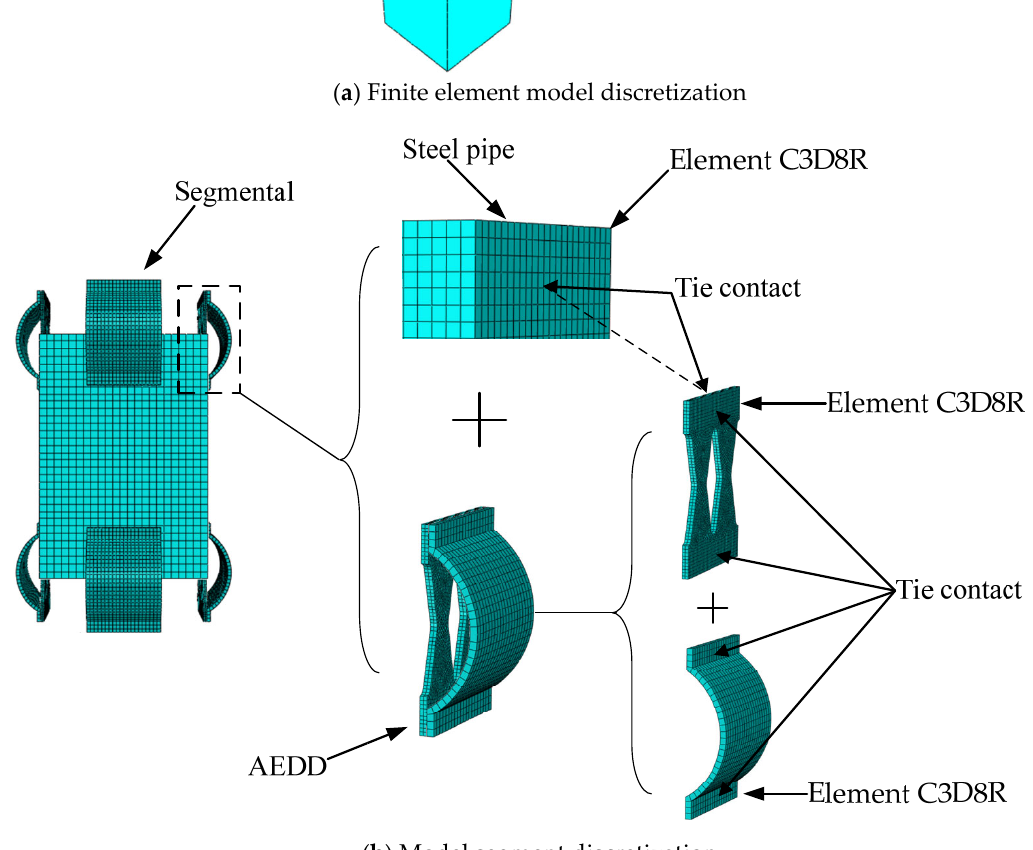
Figure 11. Finite ‐ element model of PSCFSTBP with AEDD. Figure 11. Finite-element model of PSCFSTBP with The loading mode of each specimen is low ‐ cycle reciprocating loading, the loading position is at the side center of the pier cap, and the bottom of the pier column is fully constrained to form a cantilever structure. The loading mode adopts displacement control, and the horizontal offset rates of the pier top are 0.07%, 0.13%, 0.20%, 0.27%, 0.34%, 0.67%,